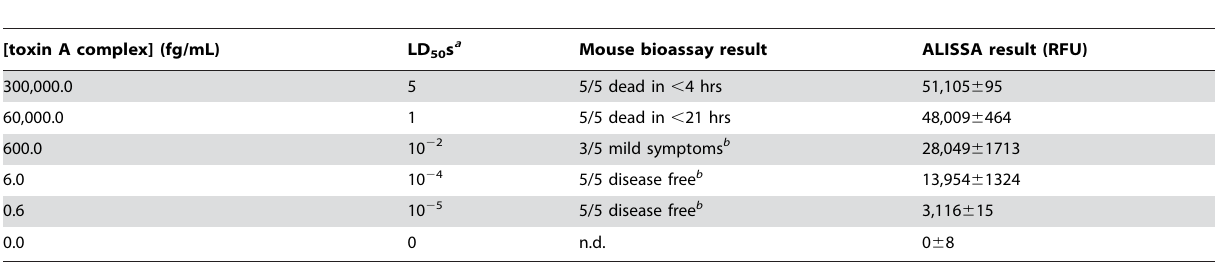
Table 2. Comparison of the mouse bioassay with BoNT/A